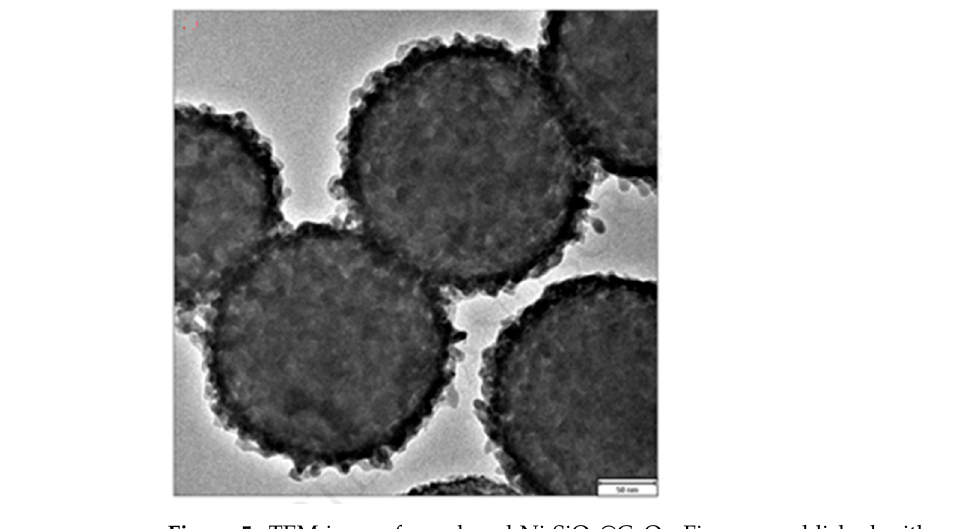
Figure 5. TEM image for reduced Ni-SiO 2 @CeO 2. Figure republished with permission from [91] Copyright Elsevier, 2018.